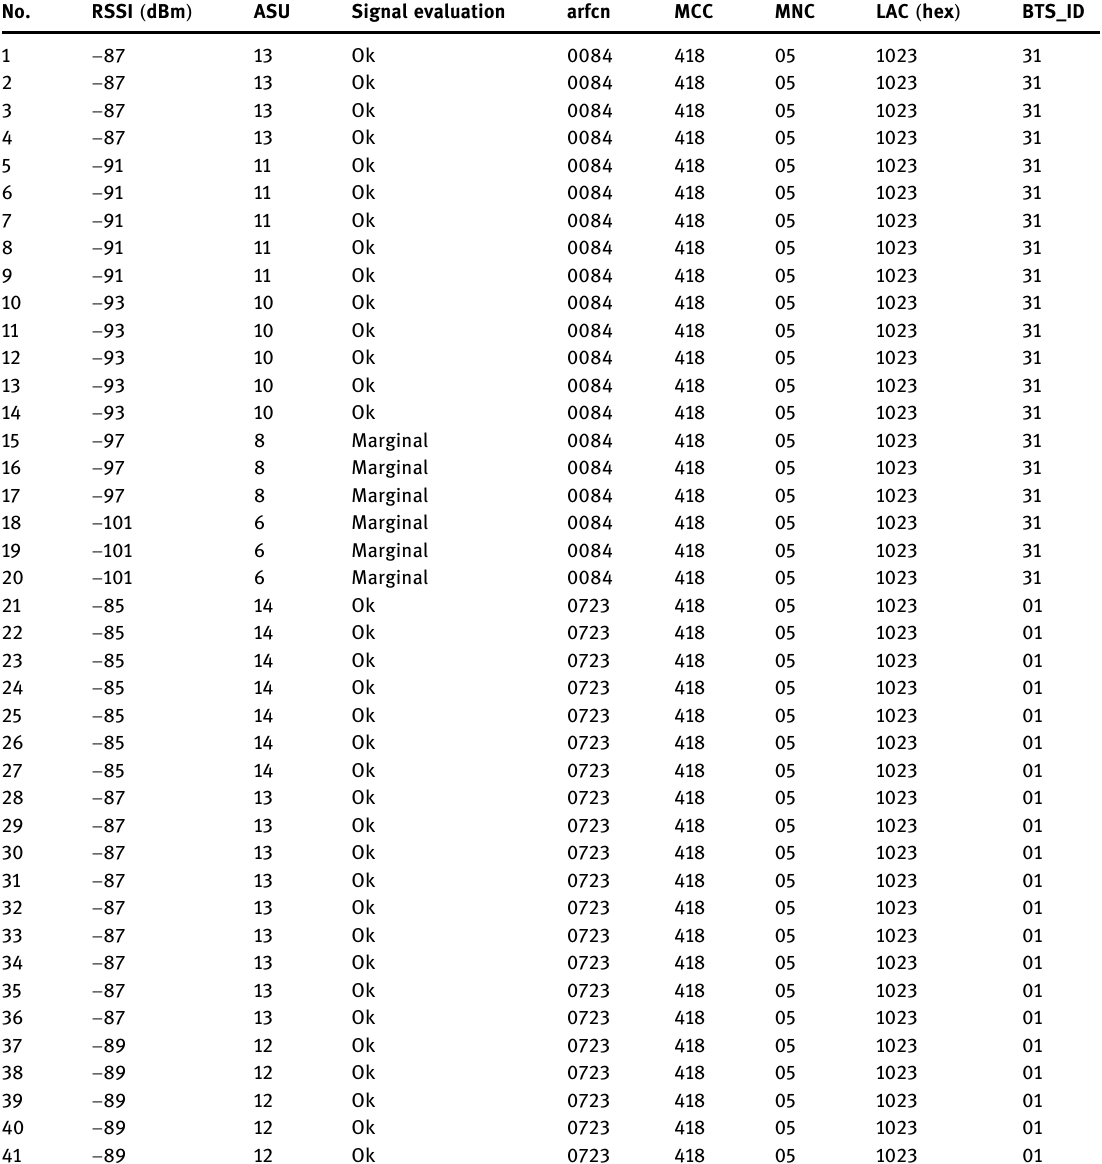
Table 2: Results of mobile network BTS information after applying the